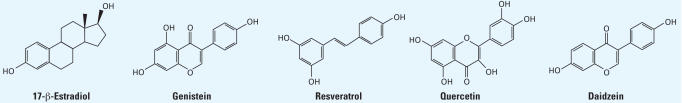
Chemical structures of E2 and the phytoestrogens resveratrol, genistein, quercetin, and daidzein.